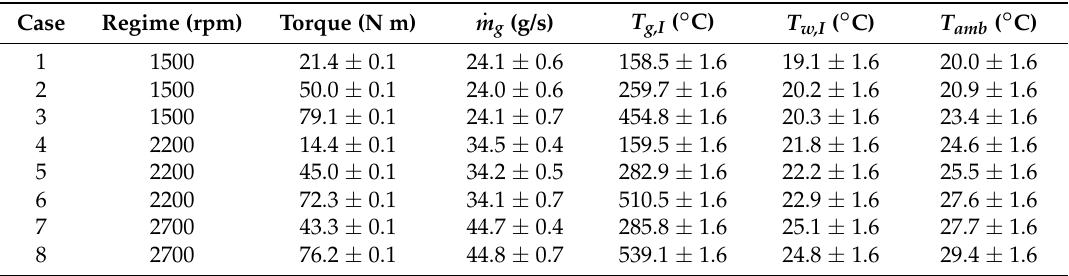
. m g , temperature of the exhaust gas